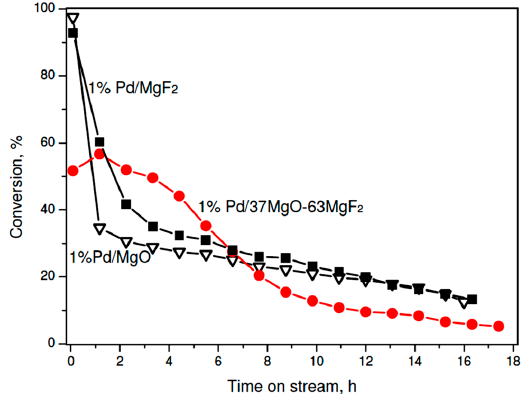
Figure 3. Time on stream behavior of 1 wt % Pd/MgO-MgF 2 (carbonate) catalysts in CCl 4 hydrodechlorination at 90 °C.